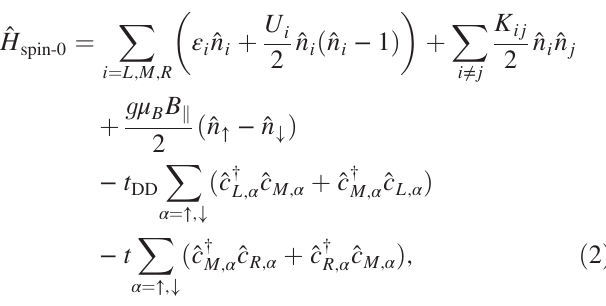
FIG. 2. Schematic of the even-occupied spinless multielectron dot, coupled to the two-electron double dot. Symbols ε indicate the single-particle energies of the lowest orbitals in the double dot and the lowest unoccupied orbital in the multielectron dot. Arrows indicate tunnel couplings within the double dot ( t and between the middle and the multielectron dot ( t ). For simulations, the detuning of the right dot relative to the left dot is varied ( ε (cid:2) ), which allows the generation of energy spectra [as in Fig. 3(b)] and comparison to experimental leakage spectroscopy data [see discussion of Figs. 3(c) and